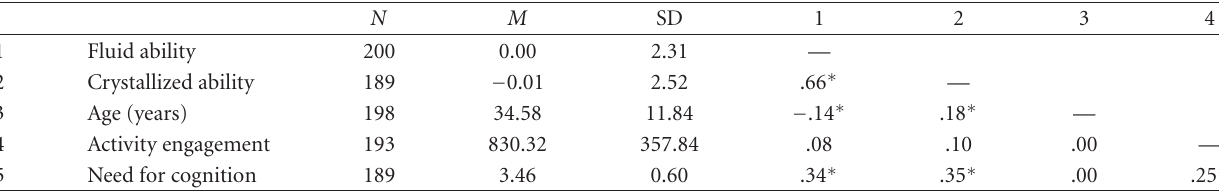
Table 2: Correlations and descriptives for study variables.